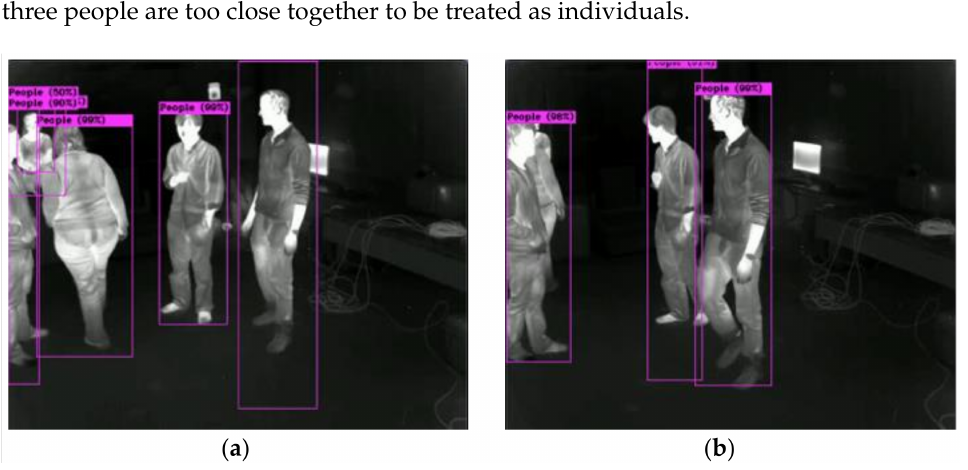
Figure 10. Ground truth for occluded objects: ( a ) five objects and ( b ) three